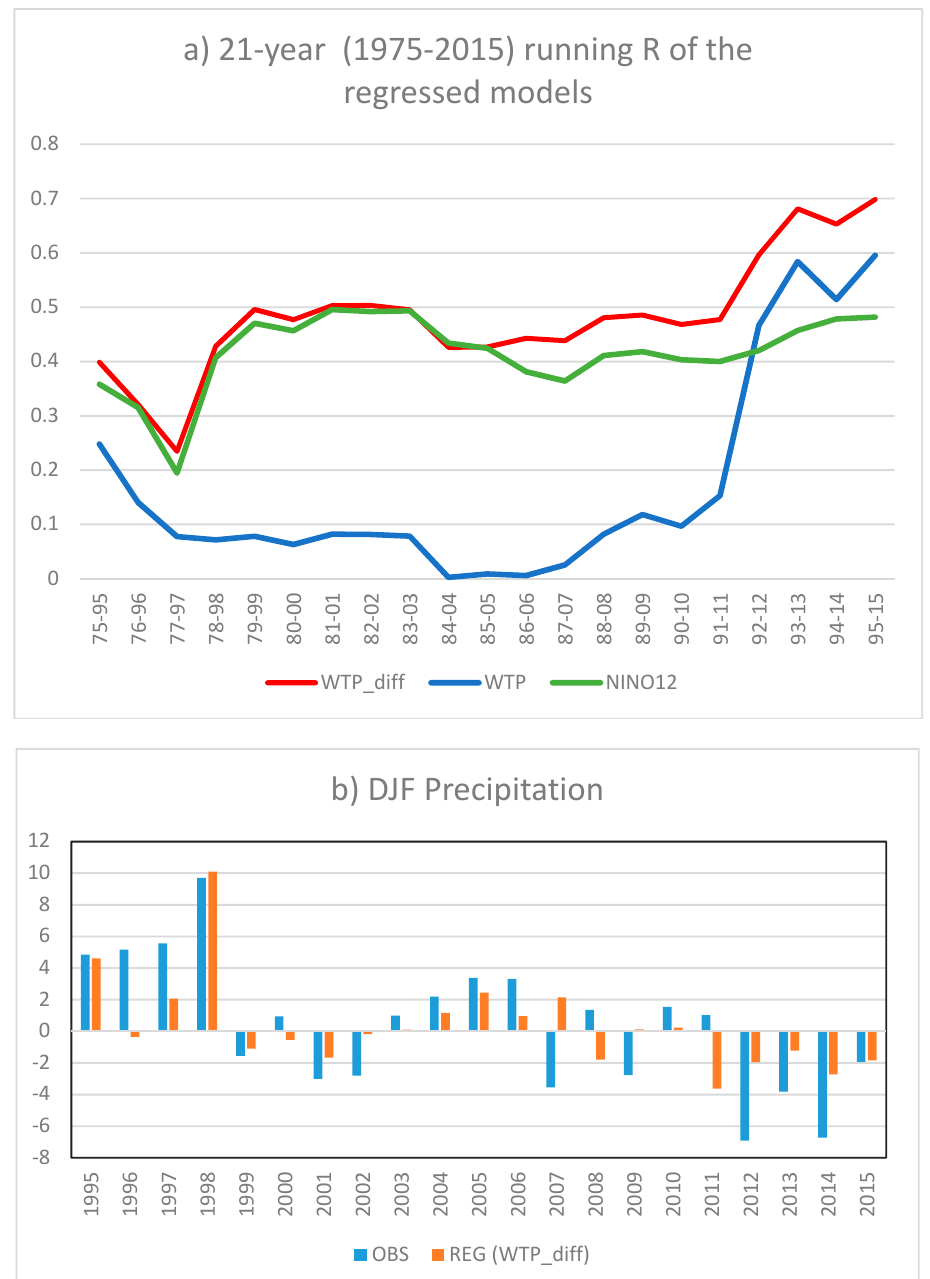
Figure 9. ( a ) Correlation coefficients (21-year running results from 1975 to 2015) between the observed DJF precipitation and the regressed precipitation using three single dependent variables. ( b ) Observed DJF precipitation (blue bar, inches) and regressed DJF precipitation (orange bar, inches) using WTP diff for a recent period of 21 years (1995–2015).